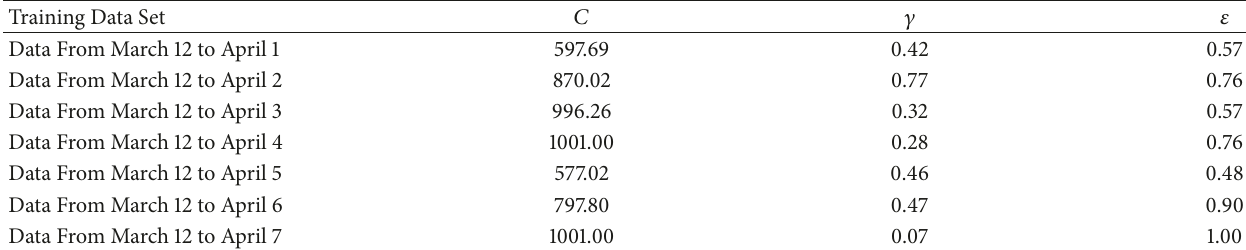
Table 1: The optimal parameter sets of the second training data set at Zhujianglu station.